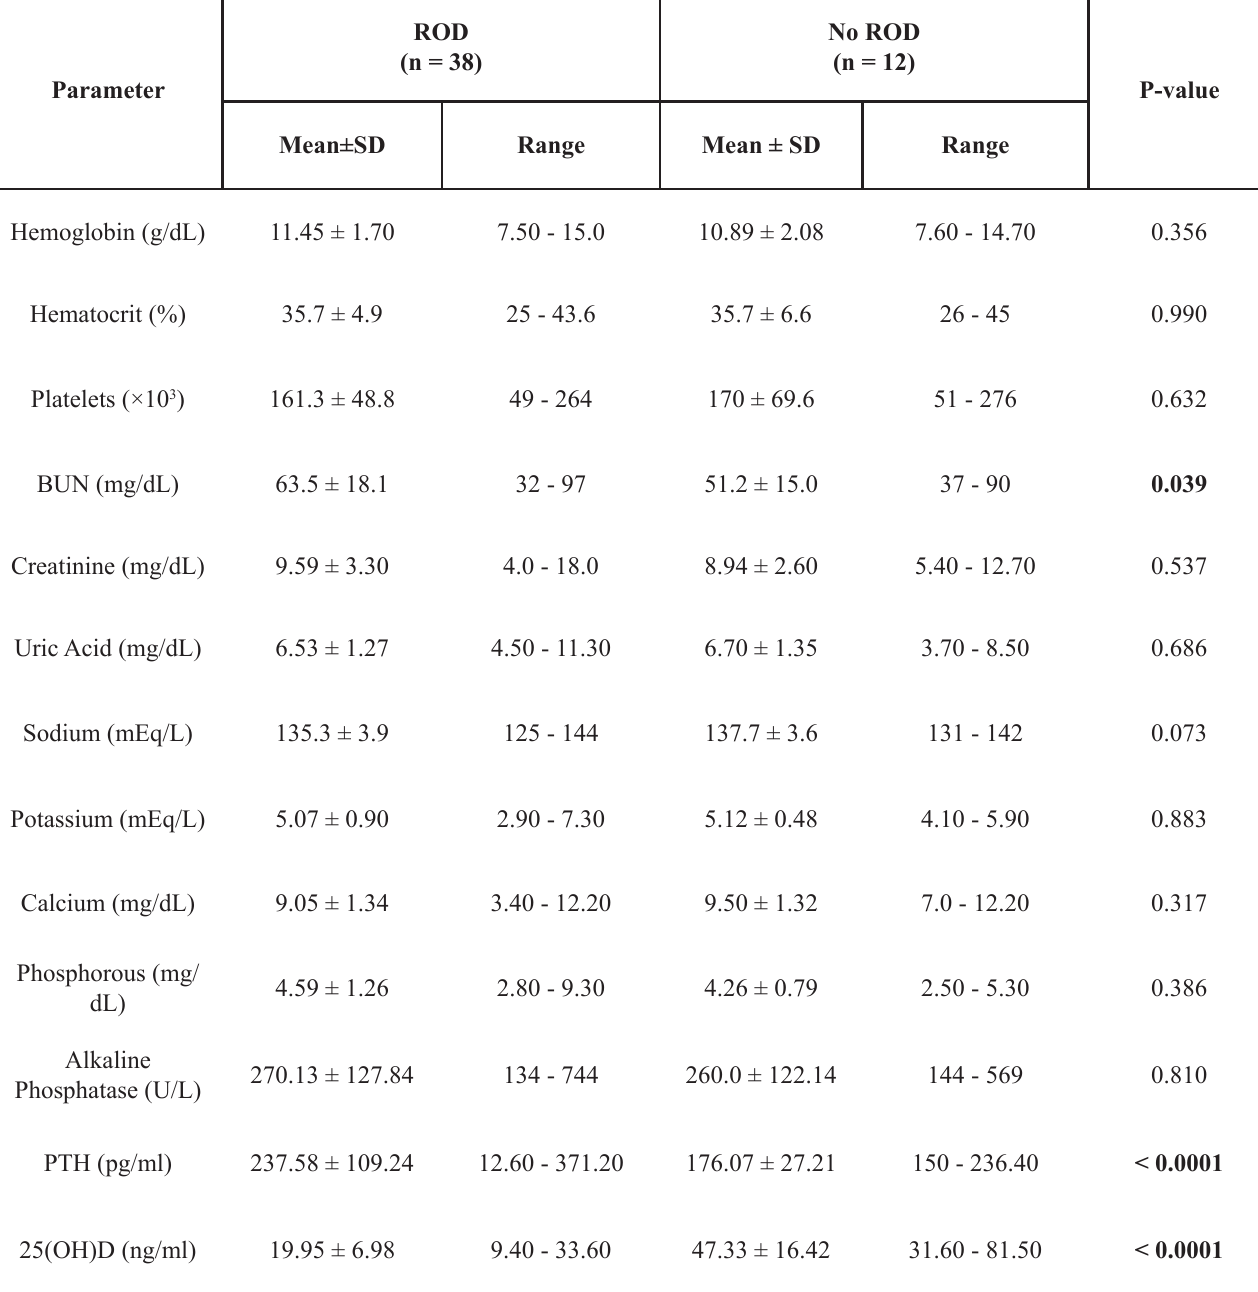
Table 2 . Laboratory parameters among ESRD patients with and without ROD